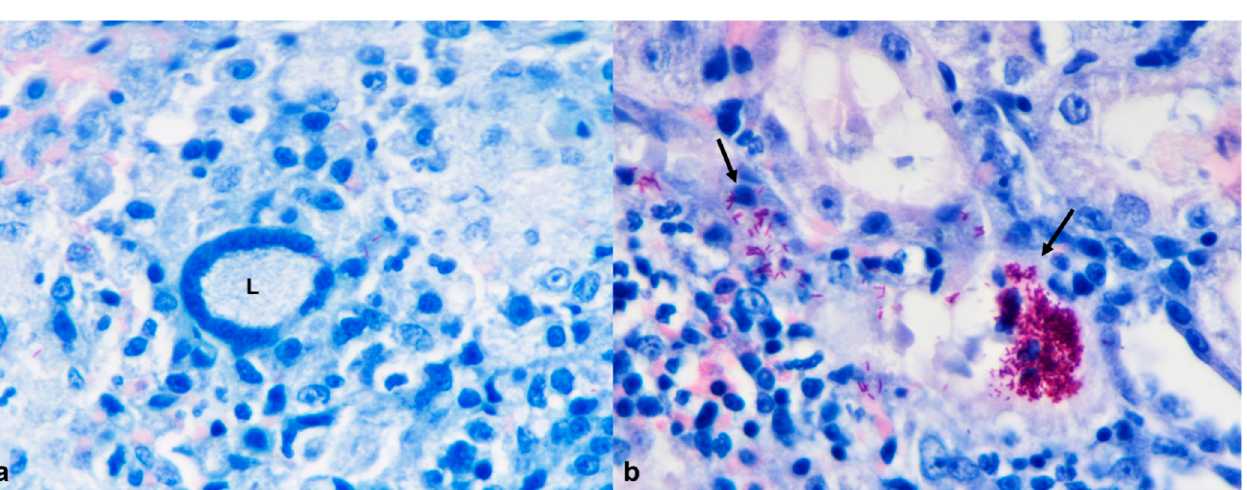
Figure 4. African pygmy hedgehog, liver. Case 4, Bile duct hyperplasia and hepatic steatosis. ( a ) Postmortem examination of the abdominal cavity demonstrating hepatomegaly (*); ( b ) Bile duct hyperplasia. Photomicrograph of the liver showing diffuse macrovesicular steatosis and severe proliferation of bile ducts associated with bridging fibrosis (HE, 20×). Inset: The bile duct epithelial cells showing cytokeratin (AE1/AE3) immunoreactivity, (20×); ( c ) The hyperplasic bile ducts are lined by cuboidal to polygonal epithelial cells with vesicular nuclei (HE, 400×); ( d ) Some of the tubular structures contain a PAS-positive material (arrows; PAS, 200×).